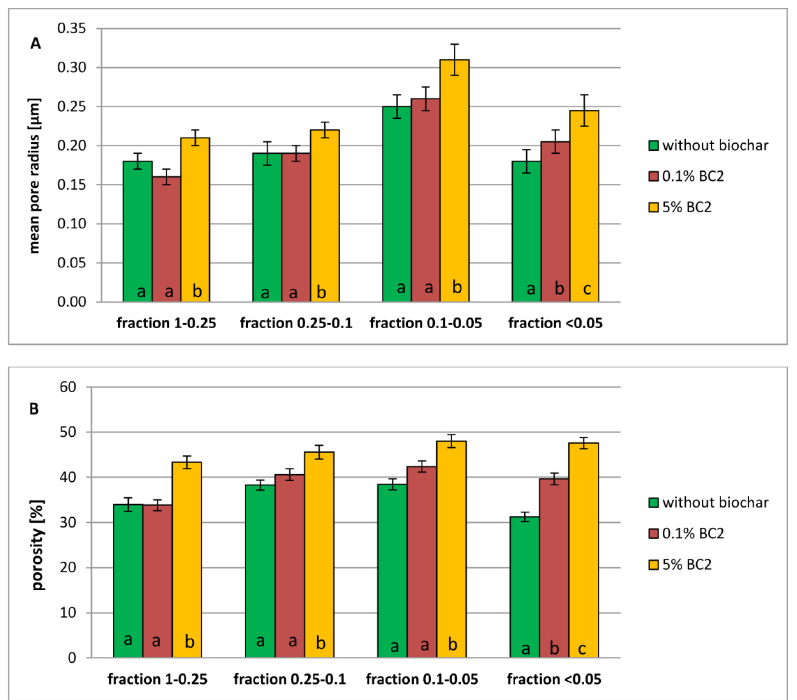
Figure 8. Porosity characteristics of the cylinders remolded using selected Dystric Cambisol fractions with and without sunflower husk biochar (BC2): ( A ) mean pore radius, ( B ) porosity; the bars correspond to the standard deviation.